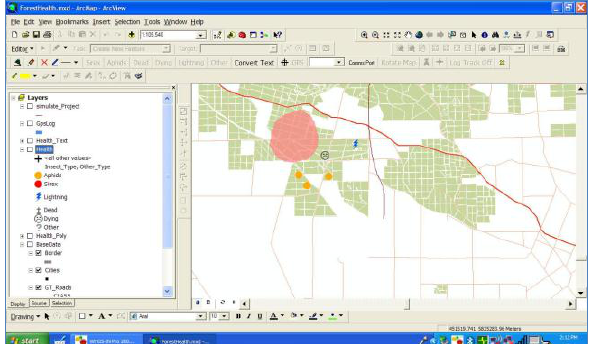
Figure 3. Display of captured